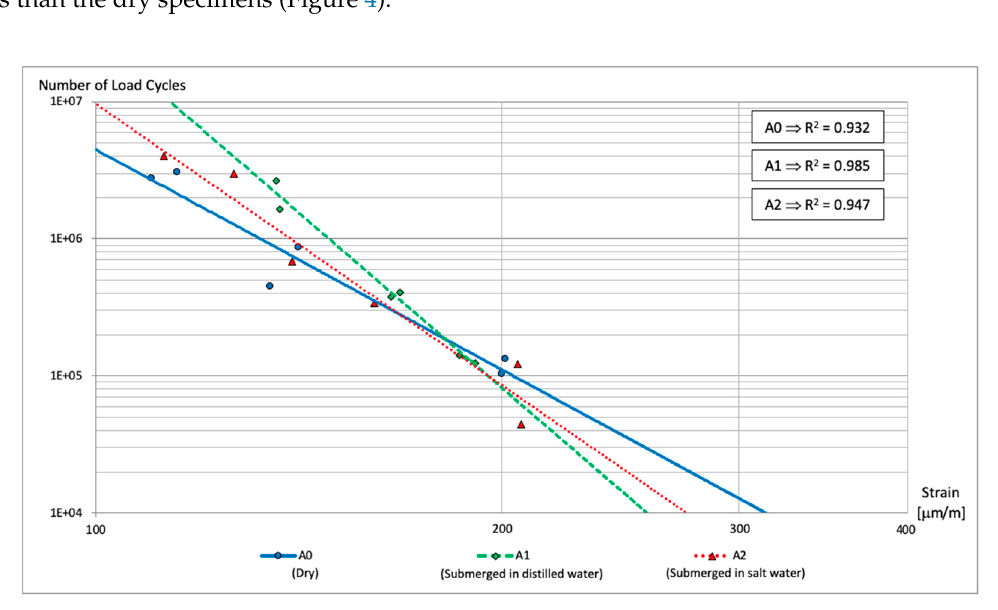
Figure 5. Fatigue test: specimens subjected to five freeze–thaw cycles. The series that have been subjected to a year outdoors (C) obtain similar values for all specimens, being for C1 the number of load cycles slightly lower for high strain values (Figure 6).